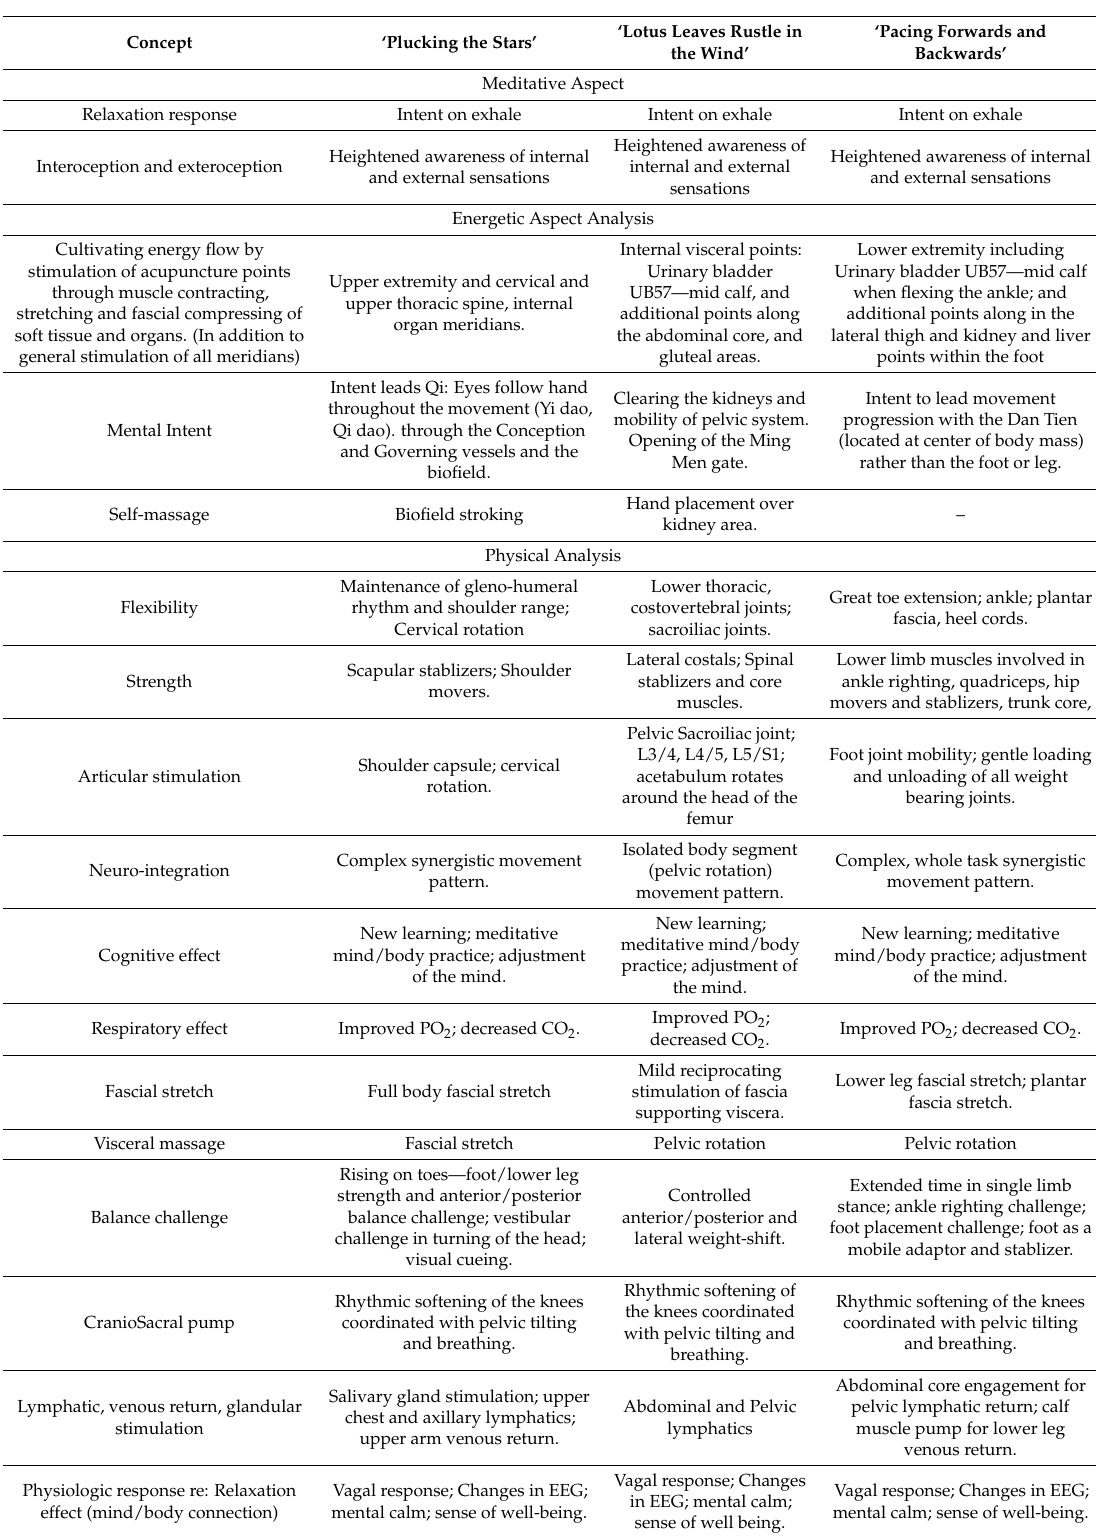
Table 1. Summary of comparative aspects of three Qigong exercises from the 24-Posture Qigong forms: ‘Plucking the Stars’, ‘Lotus Leaves Rustle in the Wind’, and ‘Pacing Forwards and